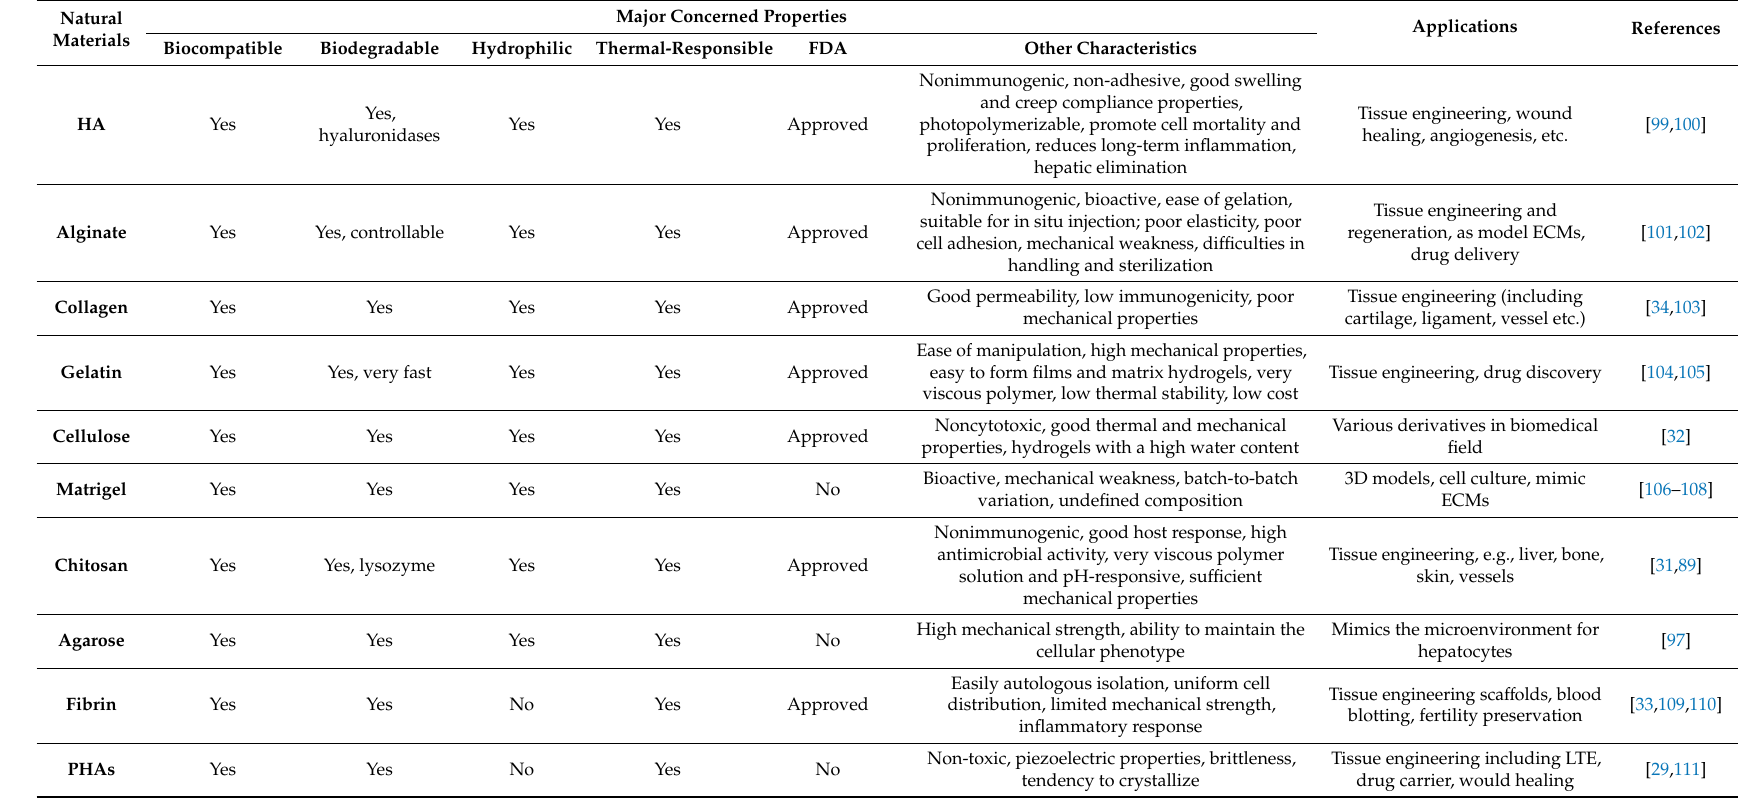
Table 1. Characteristics and applications of natural